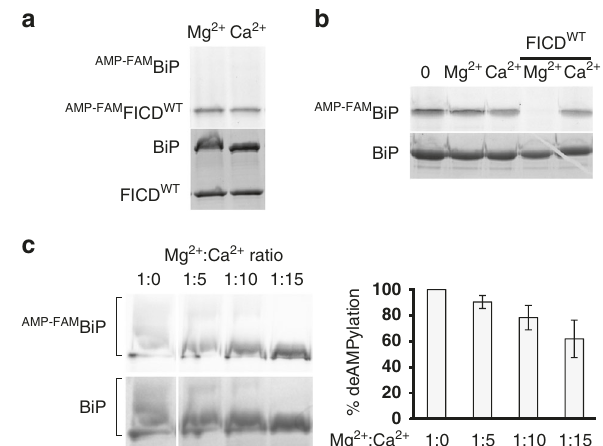
Fig. 4 DeAMPylation of BiP by FICD requires Mg 2 + and is inhibited by Ca 2 + . a . FICD WT does not AMPylate the BiP chaperone. Reactions were carried out for 1 h in the presence of 1 mM Mg 2 + or 1 mM Ca 2 + . The level of AMPylated proteins (indicated as AMP-FAM FICD WT and AMP-FAM BiP) was measured by fl uorescence. The total amount of proteins measured by Coomassie staining in the same sample is shown. b Ca 2 + inhibits deAMPylation of BiP by FICD/HYPE WT . BiP was fi rst AMPylated for 1 h by the hyperactive FICD E234G mutant in the presence of 100 μ M Mg 2 + , then AMP-FAM BiP was puri fi ed to remove Mg 2 + , PPi, and ATP-FAM. DeAMPylation of AMP-FAM BiP was then triggered by addition of wild-type or mutant FICD in the presence of 1 mM Mg 2 + or 1 mM Ca 2 + . AMP-FAM BiP levels were determined by measuring the fl uorescence intensity of each band. The total amount of BiP measured by Coomassie staining in each sample is shown. c The net deAMPylation ef fi ciency of FICD WT is tuned by the Mg 2 + /Ca 2 + ratio. DeAMPylation was carried out as in b using a fi xed Mg 2 + concentration (200 µ M) and 0, 1, 2 or 3 mM Ca 2 + . AMPylation levels were measured by fl uorescence, normalized to the fl uorescence intensity of FICD, and expressed as the percentage of maximal deAMPylation level obtained in the absence of Ca 2 + . All data have p values <0.05 with respect to the control in the absence of Ca 2 + . The total amount of BiP measured by Coomassie staining in each sample is shown. All experiments were done in duplicate. Error bars correspond to standard deviations. Source data are provided as a Source Data fi